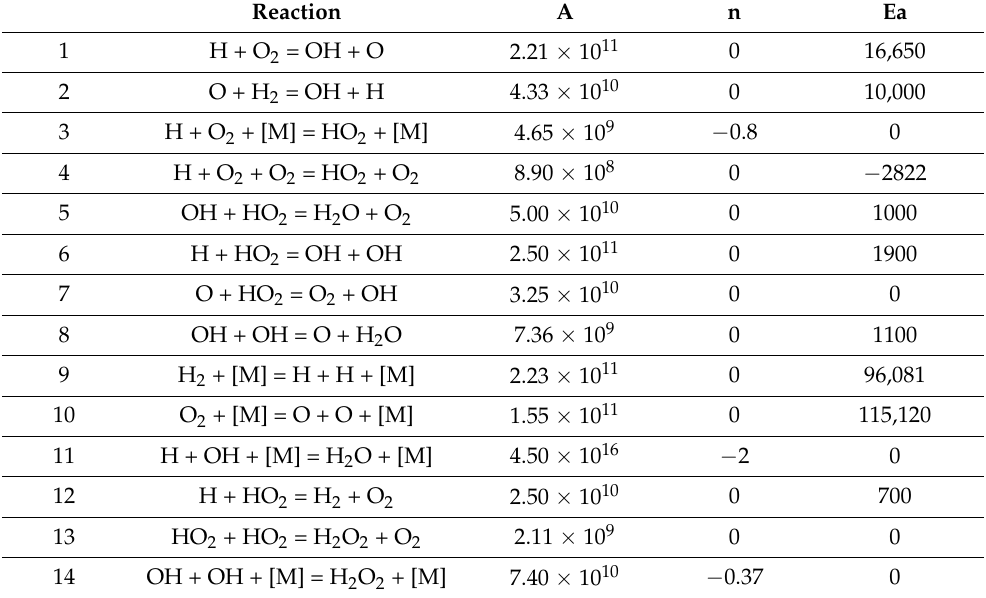
Table 4. CO/H 2 /O 2 mechanism with rate coefficients in the form k = A · T n · exp ( − Ea/RT) , A